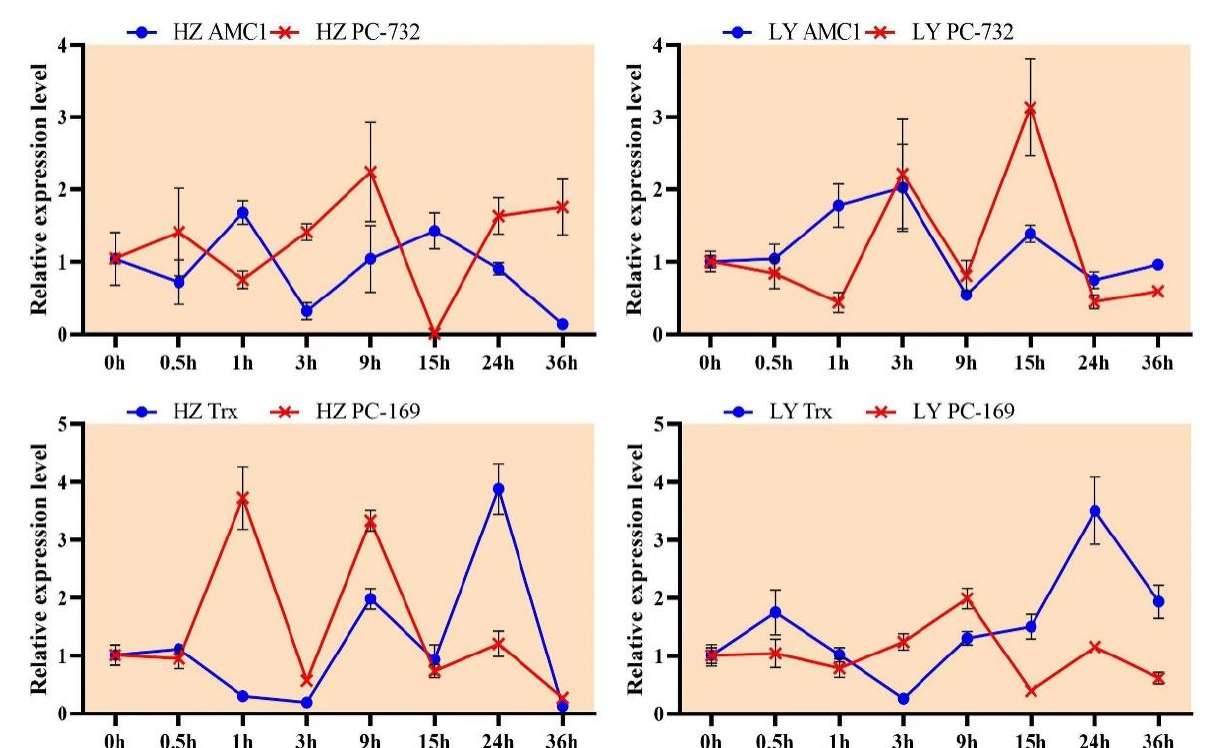
Figure 9. The expression profile of two novel miRNAs (PC-732 and PC-169) and their corresponding targets ( AMC 1 and Trx ) in HZ ( left ) and LY ( right ).